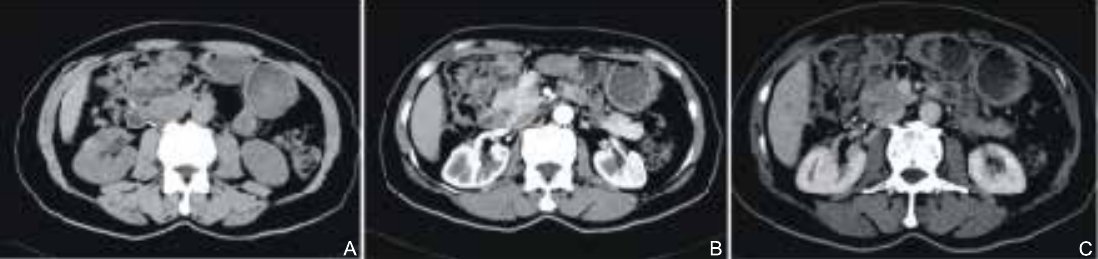
Figure 3 Unenhanced and enhanced computed tomography (CT) scan showed a tumor of 10 mm ×10mm in the duodenal papilla (A). In addition, tumor showed heterogeneous enhancement in arterial (B) and the venous phase (C).